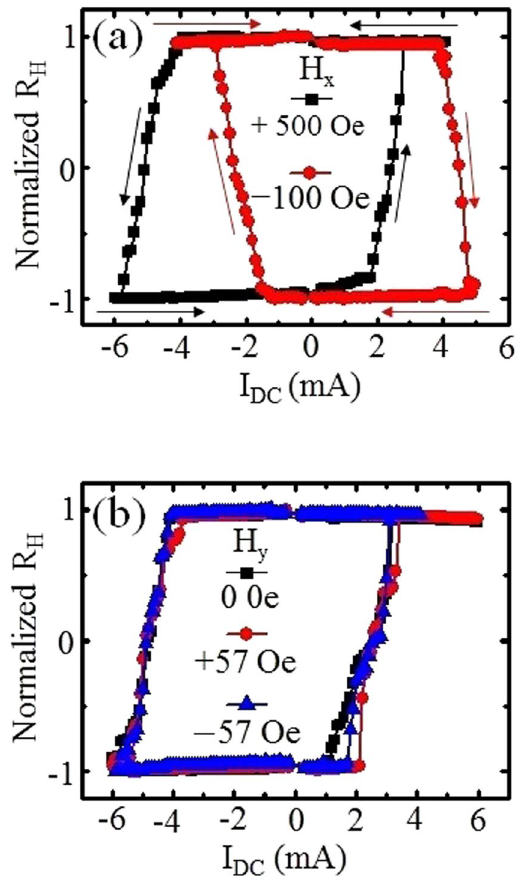
Figure 5. Current-induced magnetization switching with an in-plane external magnetic field: ( a ) R H -I loops measured by sweeping DC current with a fixed in-plane magnetic field along the (black) + x and (red) − x directions. ( b ) Measured R H -I loops with sweeping DC current when a fixed in-plane magnetic field was applied along the (red) + y and (blue) − y directions together with the loop for (black) zero